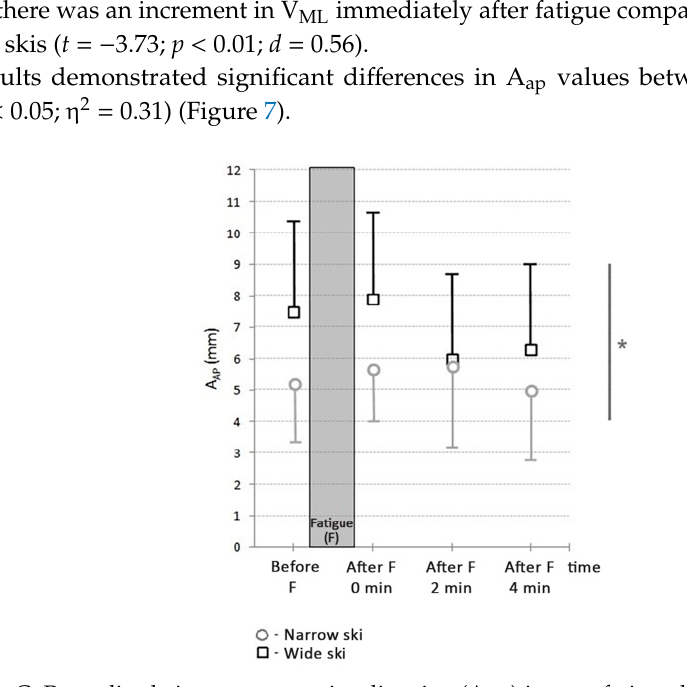
Figure 7. CoP amplitude in anteroposterior direction (A AP ) in a prefatigued state (before F) and at different times after fatigue (after F) with two different ski waist-widths. * depicts statistically significant difference between all-narrow against all-wide waist-width measurements.